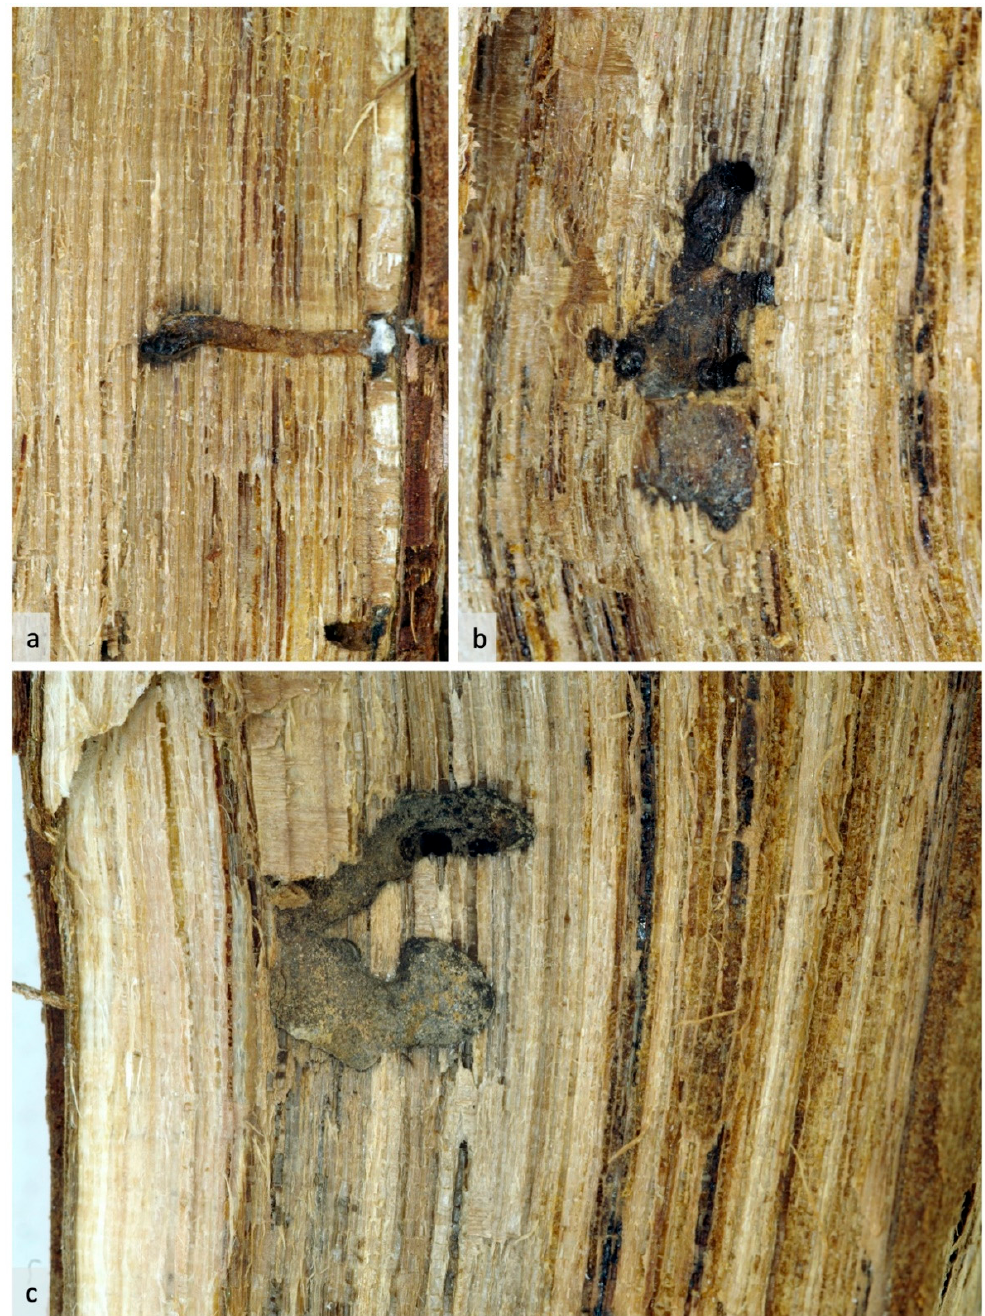
Figure 4. Grapevine longitudinal sections illustrating X. germanus galleries’ development and wood staining due to its symbiotic fungi; settlement tunnel ( a ) and rearing chambers ( b , c ). In total, 70 out of 809 grapevines were attacked by X. germanus (8.7% of the total). The majority of the infested plants were concentrated on the west side of the field, close to a concrete wall delimiting the property. In this area, considering only the first five rows of vines, the infestation rate was 16%, with 13.4 attacked plants per row on average. The intensity of the attacks and their spatial distribution are illustrated in Figure 5.